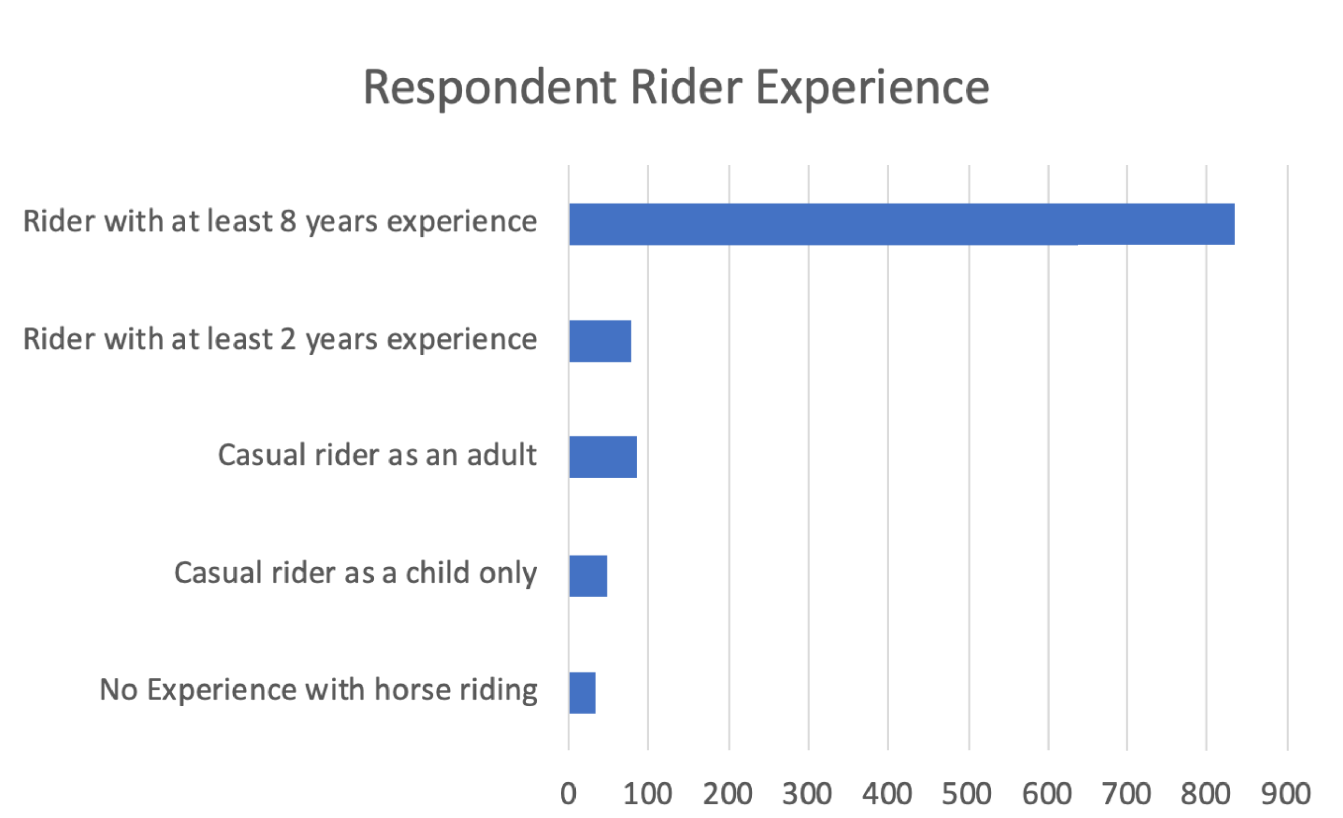
Fig 1. Respondent rider experience. Respondents’ (n = 1233) horse-riding experience. Riders with at least 8 years 77.46%, riders with at least 2 years’ experience 7.24%, casual rider as adult 7.88%, casual rider as child 4.45% and respondents with no experience with riding 2.97% (n =